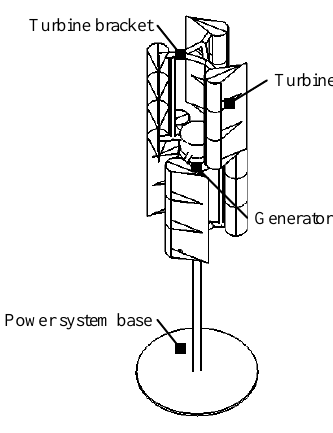
Figure 10. Three-dimensional model of the wind turbine.